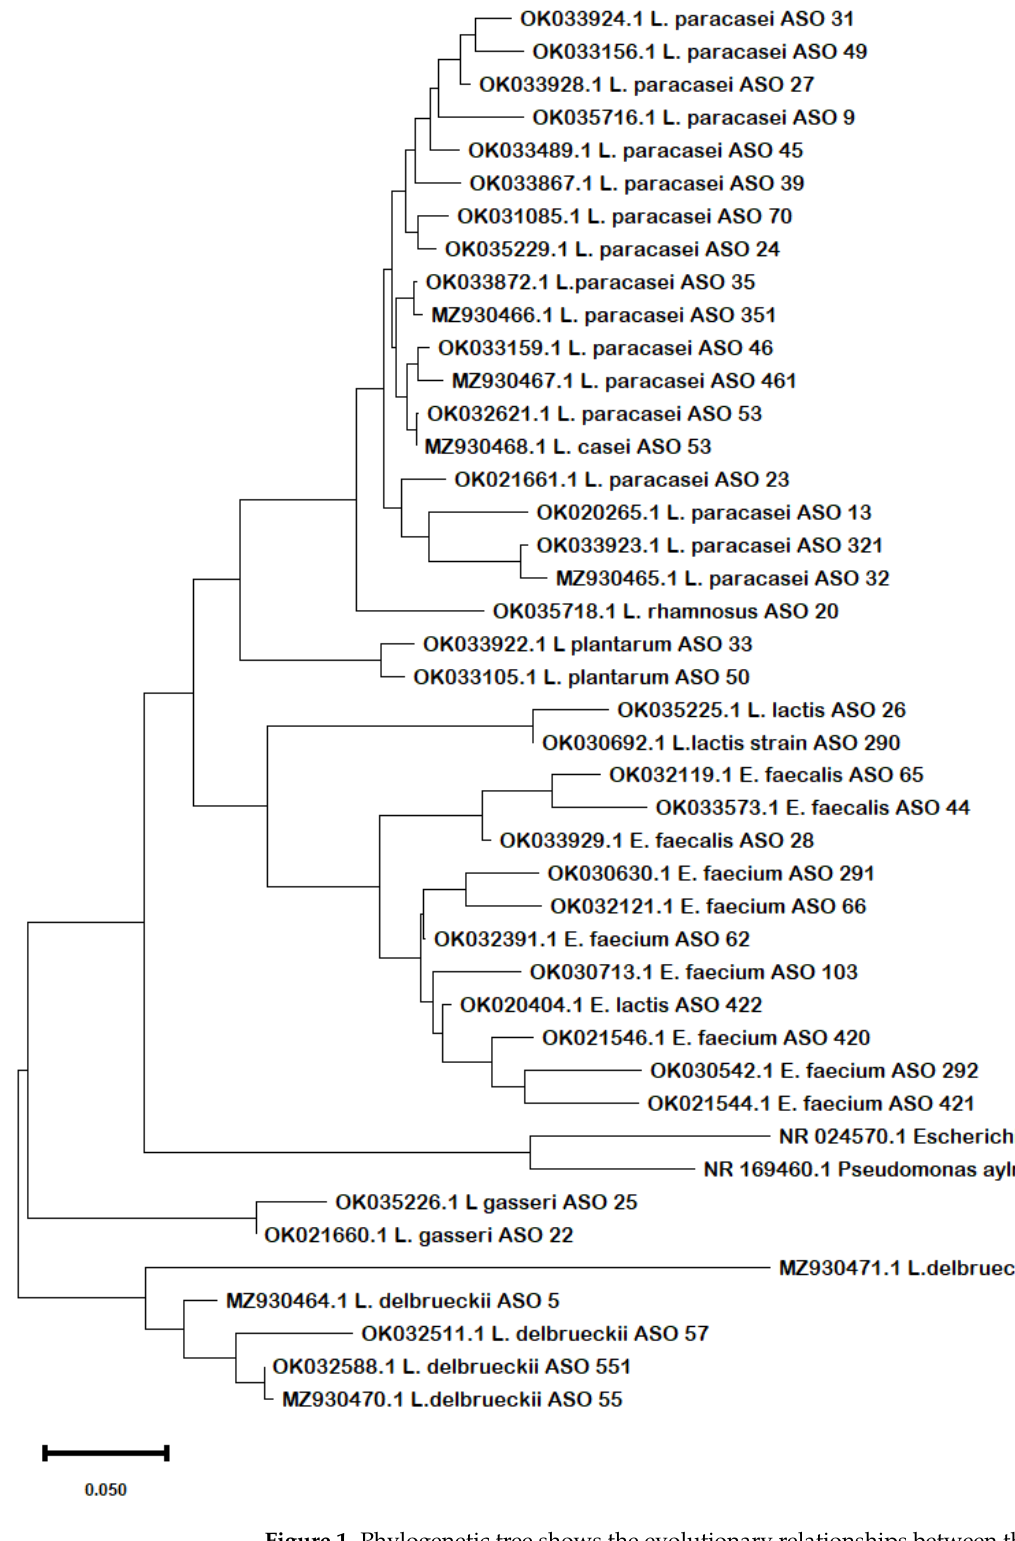
Figure 1. Phylogenetic tree shows the evolutionary relationships between the 16S rRNA sequences of the obtained concatenated nucleotide sequences of their 16S rRNA. The Maximum Likelihood tree was constructed using the MEGA X software with the Maximum Likelihood algorithm and default setting. The bar length represents 0.05 substitutions per nucleotide site. Branch support was estimated from 1000 bootstrap replicates. E. coli and Pseudomonas 16S rRNA sequences serve as outgroups to root the